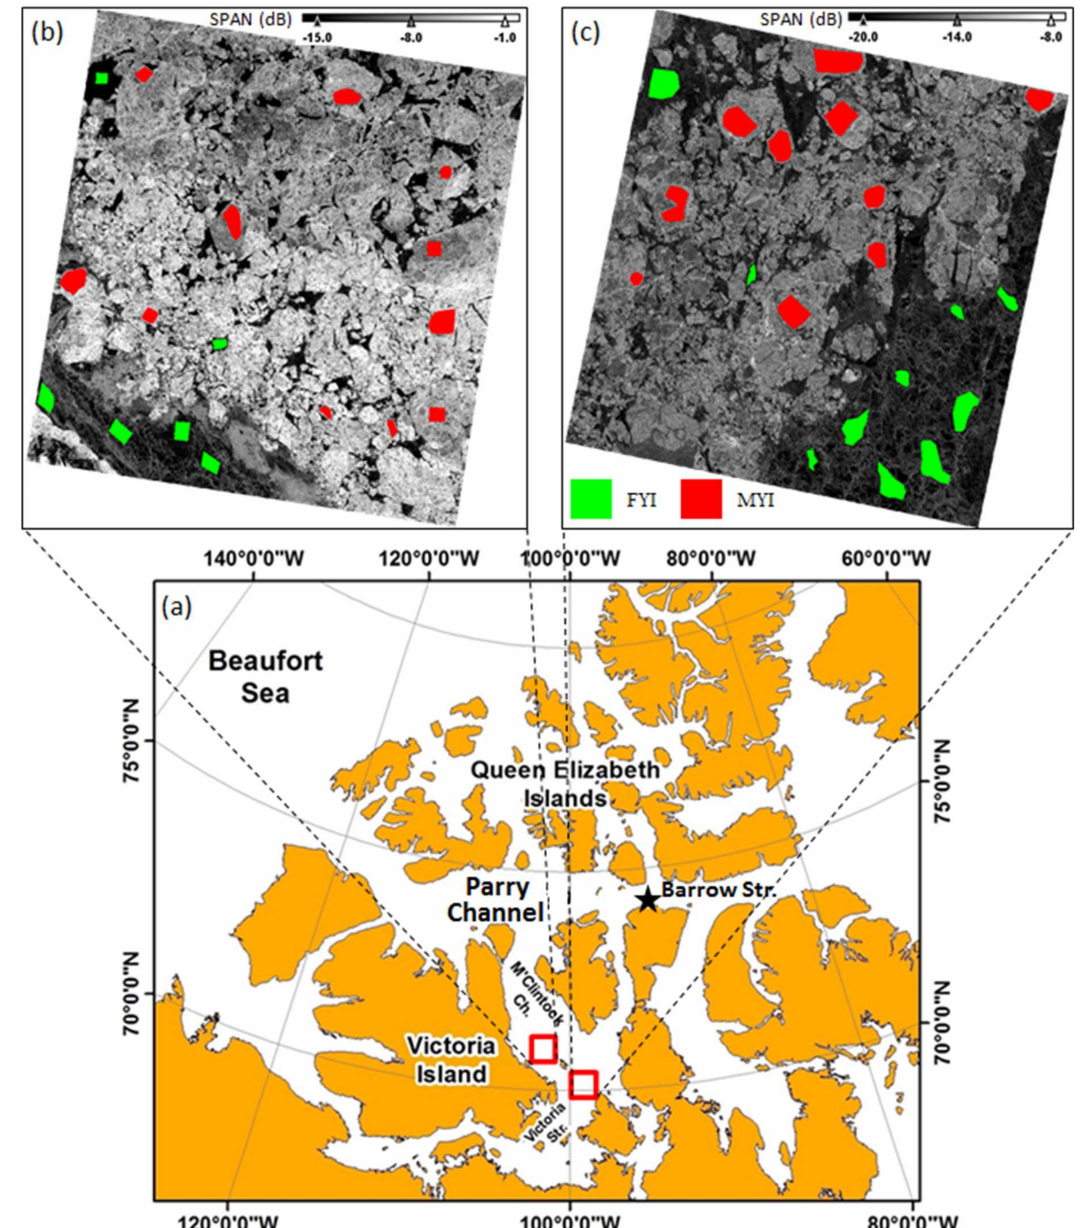
Figure 1. ( a ) Overview of the study areas (red rectangles) including the total backscattering power (SPAN) of the SAR images over ( b ) M’Clintock Channel and ( c ) Victoria Strait. Red polygons refer to selected multiyear ice (MYI) regions of interest (ROIs), while green polygons refer to selected first year ice (FYI)